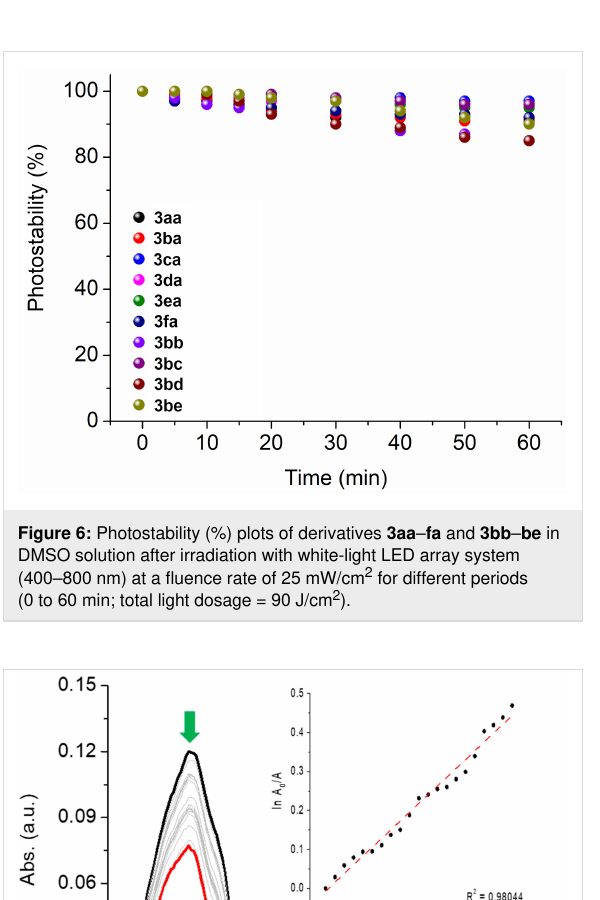
moderate singlet oxygen species generator character ( Φ Δ be- tween 0.07–0.51) after 600 s of irradiation with a red-light diode laser source ( λ = 660 nm, 100